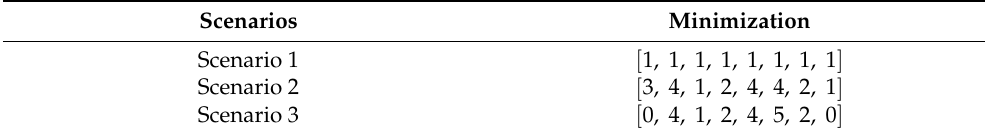
Table 8. Incidence rate vectors for Case Study #3.